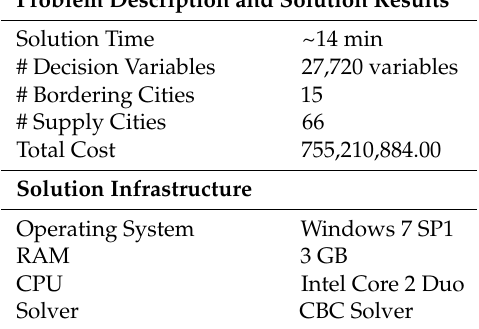
Table 5. Problem description, solution infrastructure, and